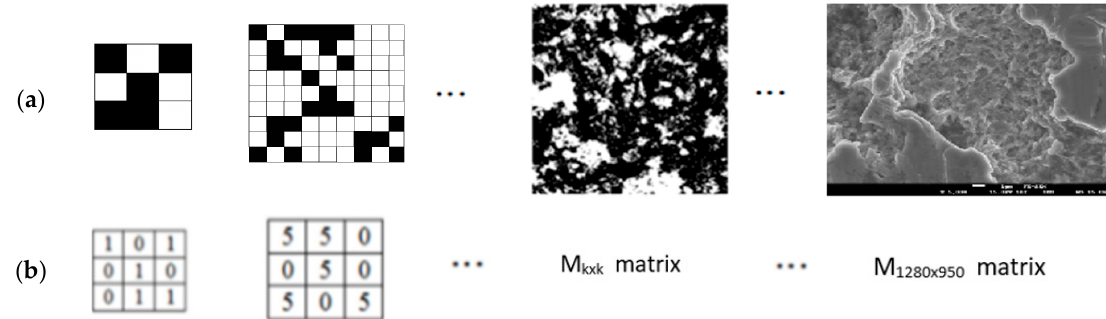
Figure 4. ( a ) Statistical self-similarity microstructure of laser-hardened material; ( b ) number of black and white pixels in the microstructure matrix of laser-hardened specimens.